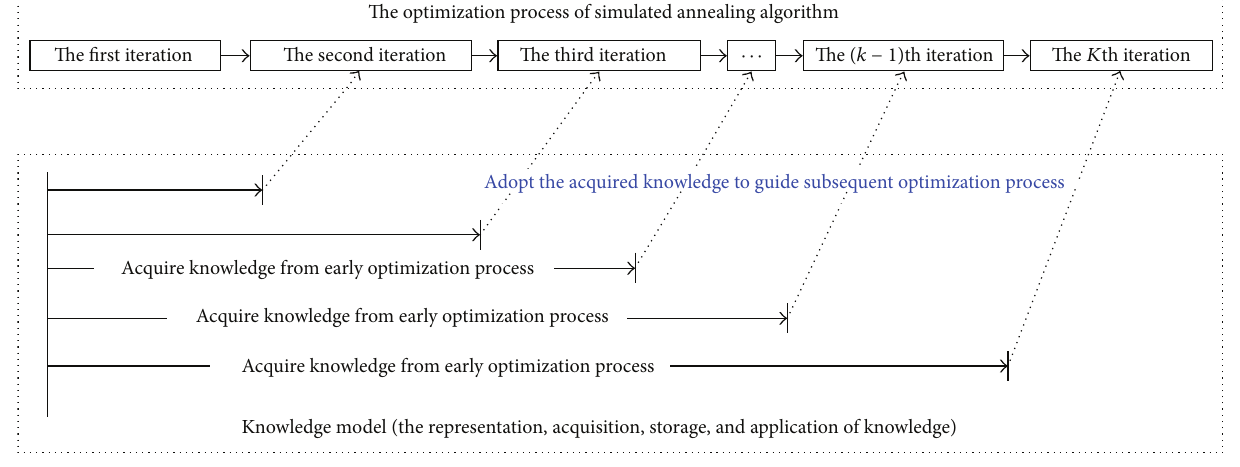
Figure 2: The operation mechanism of knowledge-based simulated annealing